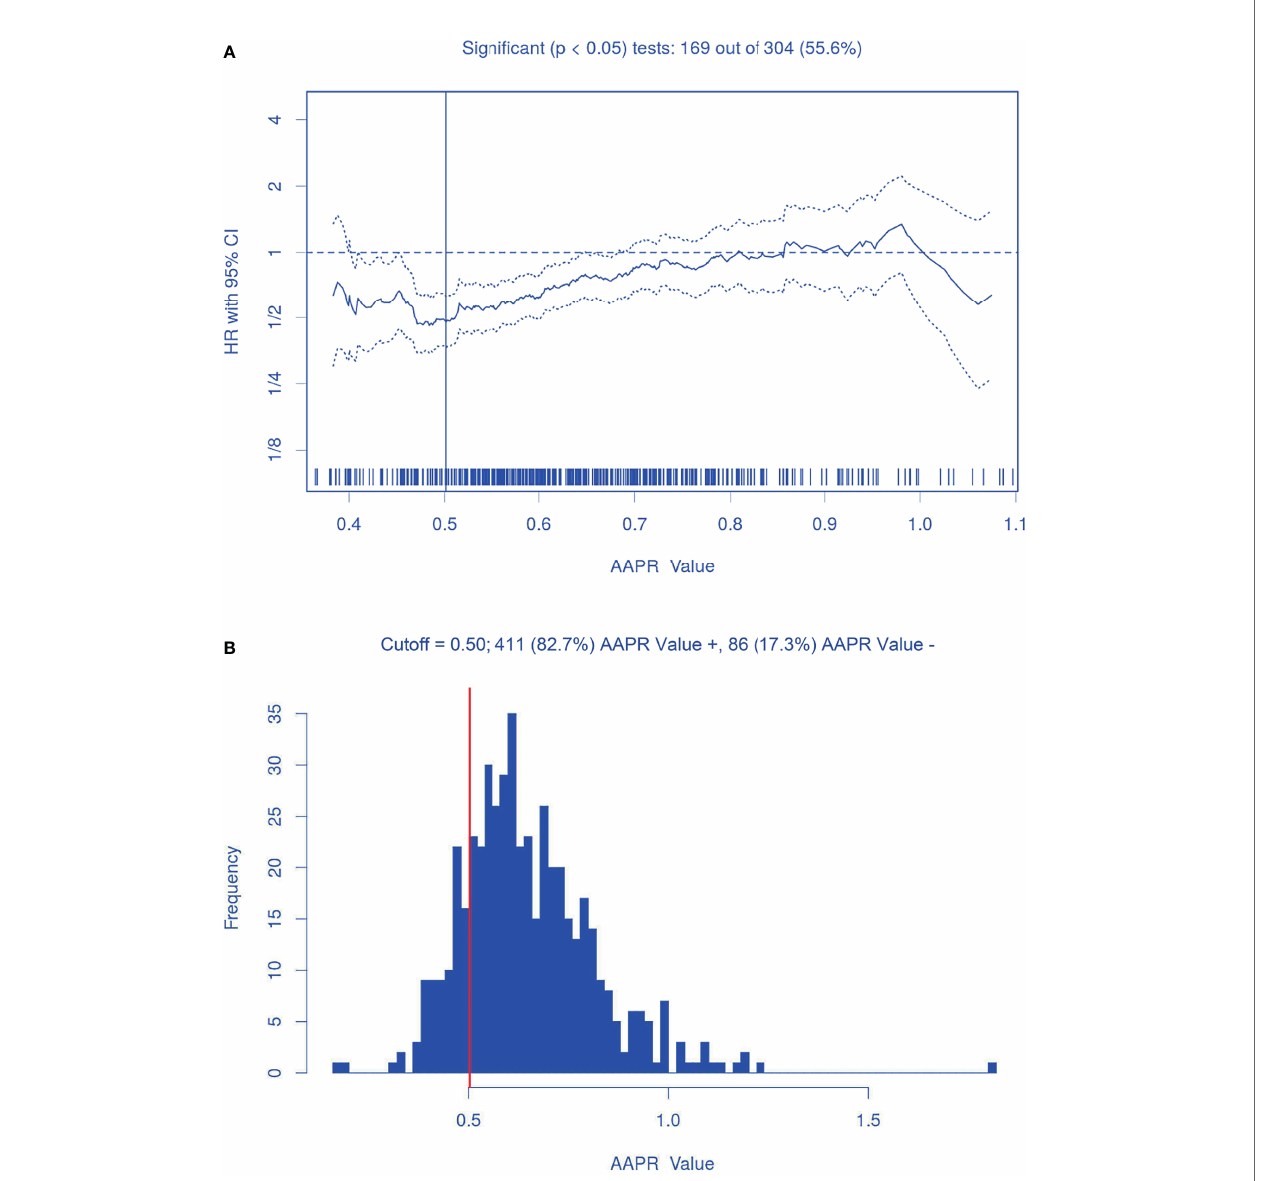
FIGURE 2 | The AAPR optimal cutoff point (0.50). (A) Hazard ratios for overall survival according to the cutoff points for preoperative AAPR; (B) Patient distribution according to preoperative AAPR. The vertical line indicates the threshold value of AAPR with the most signi fi cant split in Log-rank